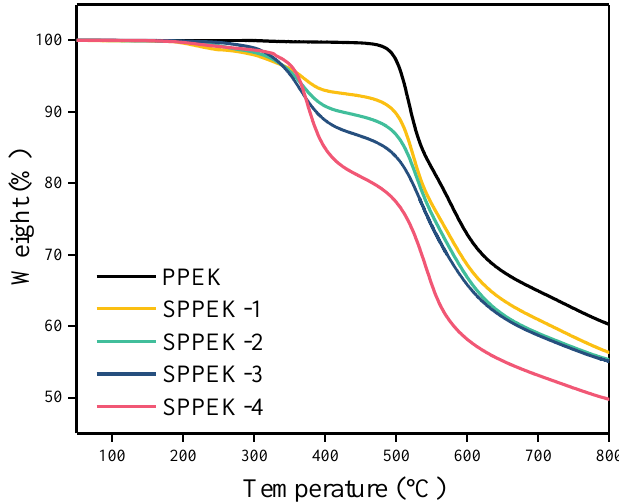
Figure 6. TGA curves of PPEK and SPPEK with different IECs.